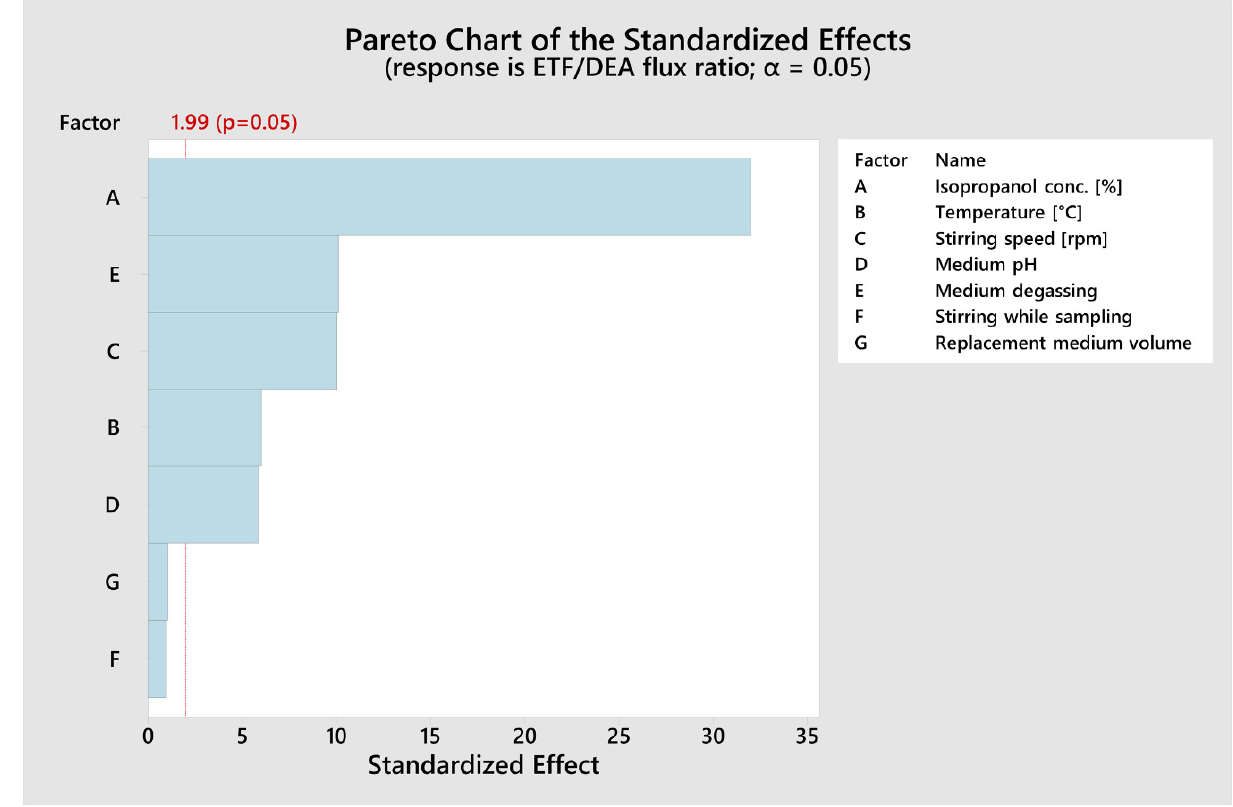
Figure 1. Pareto chart of the standardized effects of independent variables on ETF/DEA flux ratio values ( α = 0.05). The red dotted line represents the lowest significant value of standardized effect at α = 0.05.